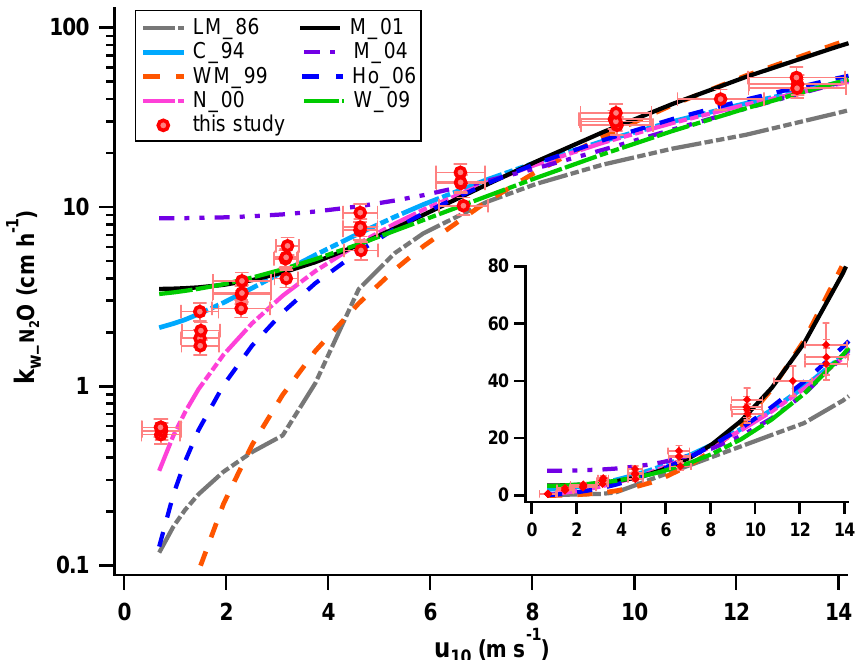
Figure 10. Comparison between the N 2 O measurements of this study (red circles) and previous k w parameterisations. The coloured lines correspond to LM_86: Liss and Merlivat (1986); C_94: Clark et al. (1994); WM_99: Wanninkhof and McGillis (1999); N_00: Nightingale et al. (2000); M_01: McGillis et al. (2001); M_04: McGillis et al. (2004); Ho_06: Ho et al. (2006); and W_09: Wanninkhof et al.